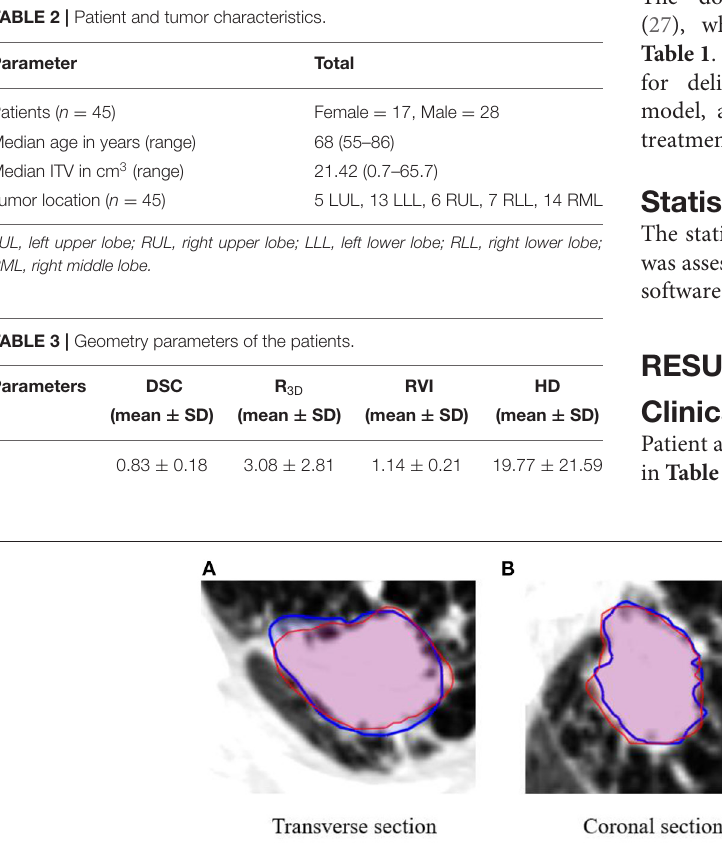
Frontiers in Public Health |